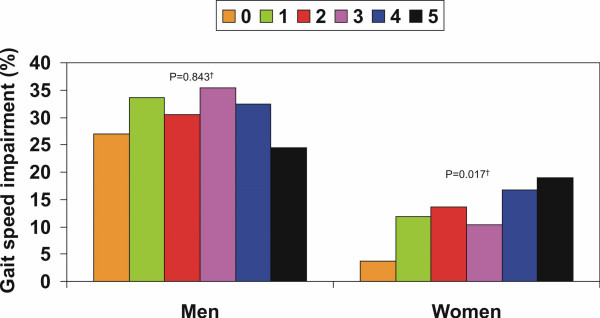
Age-adjusted prevalence of gait speed impairmenta according to number of metabolic syndrome components, NHANES 1999–2002. NHANES, National Health and Nutrition Examination Survey. aAge-adjusted to the 2000 U.S. standard population. †Denotes test for trend (P-value).